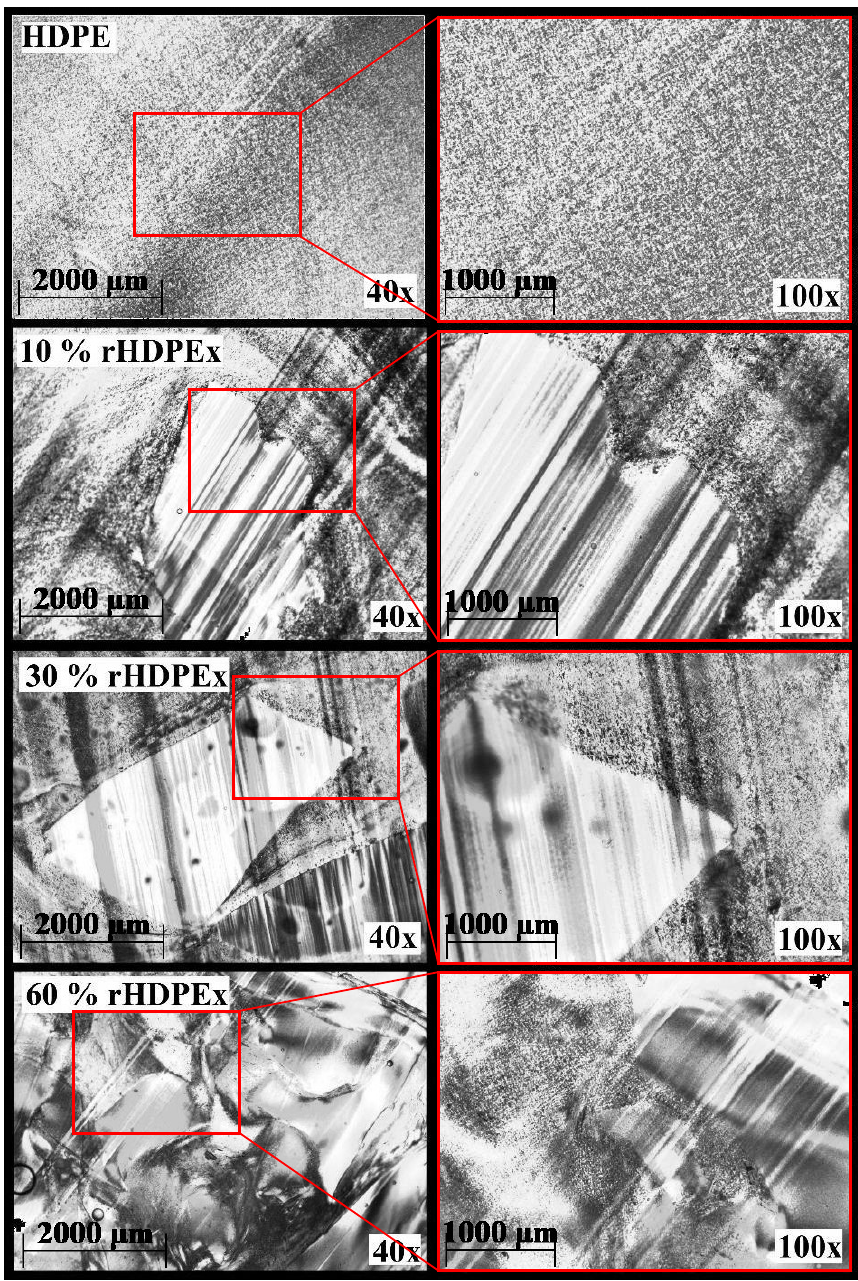
Figure 8. Microtome cuts of mixture